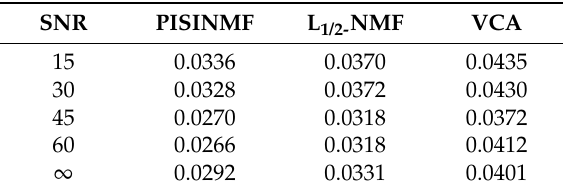
Table 4. RMSE comparison with different SNR.